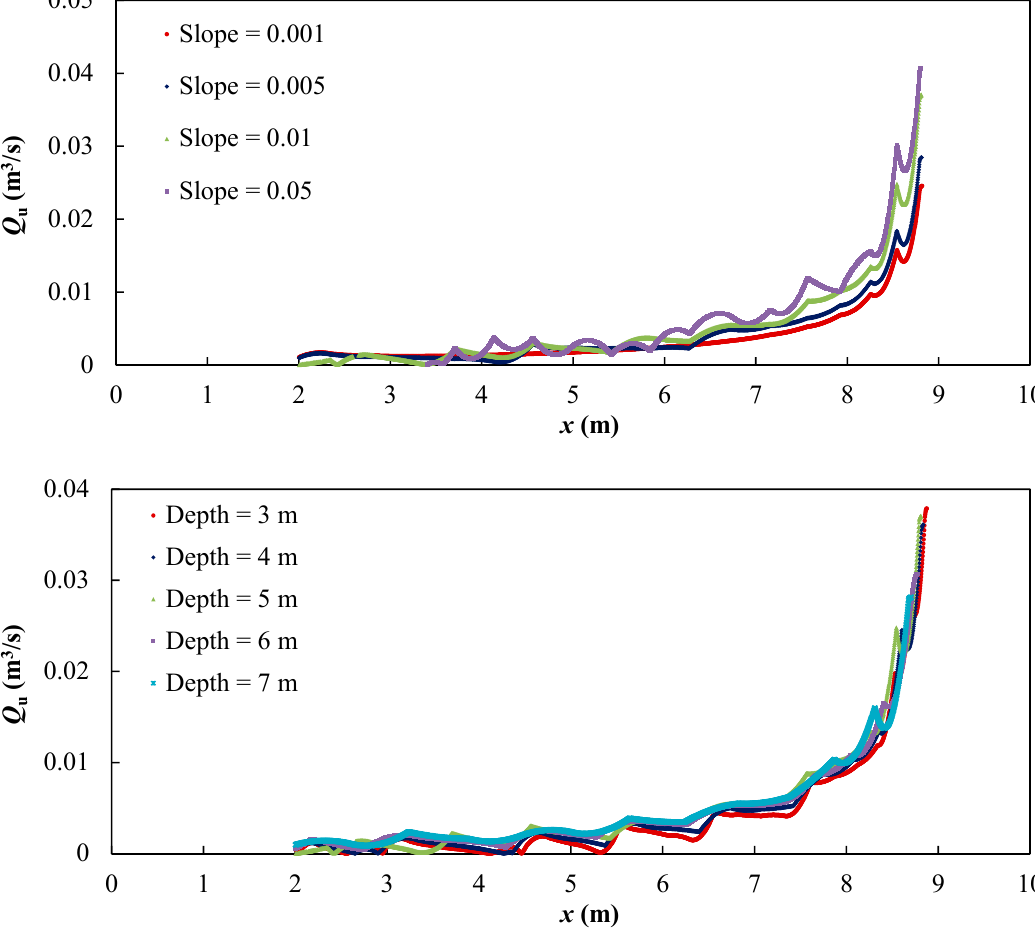
Figure 9. Influences of di ff erent slopes and depths to bedrock on Q u .